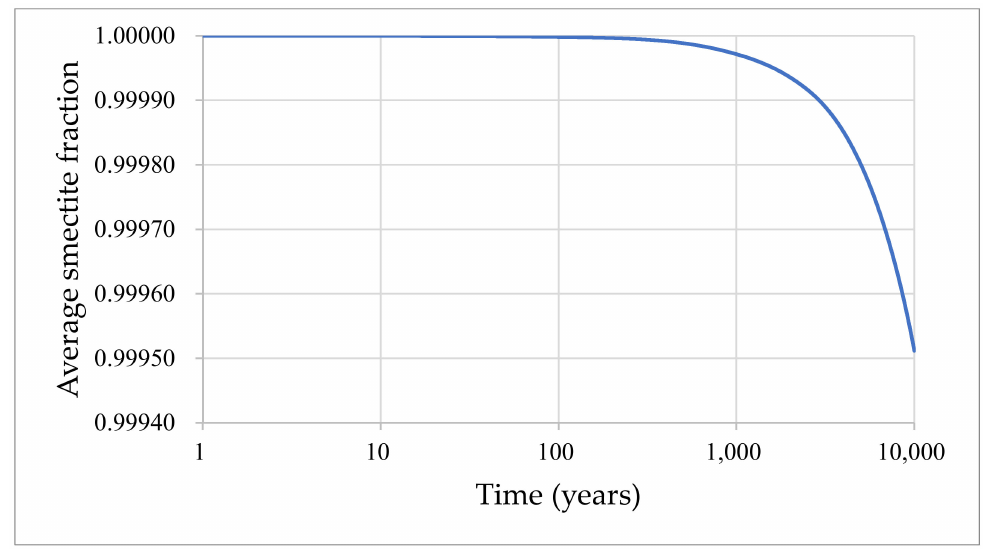
Figure 16. Average smectite fraction as a function of time on illitization